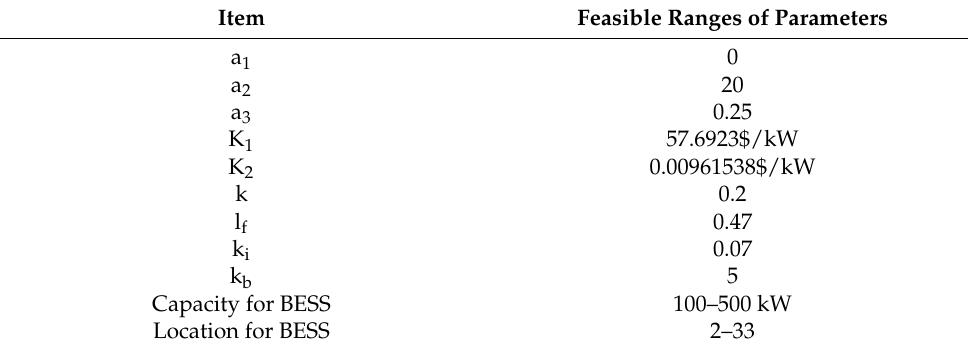
Table 4. Parameters related to objective functions of the proposed MOPSO algorithm.